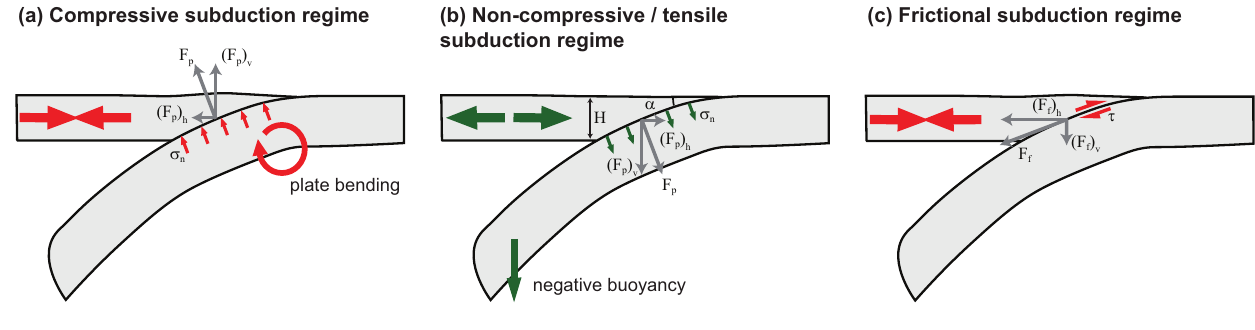
Fig. 10. Sketches of the main subduction regimes and the key parameters causing them. A compressive subduction regime is caused by the flexural rigidity of the lower plate which resists bending (a) . However, this regime is only obtained when the slab is neutrally buoyant because the negative buoyancy of the subducted lithosphere exerts a tensile non-hydrostatic normal stress on the plate boundary which generates a horizontal tension in the upper plate (b) . Finally, a horizontal compression can also be generated because of a large interplate friction (c)